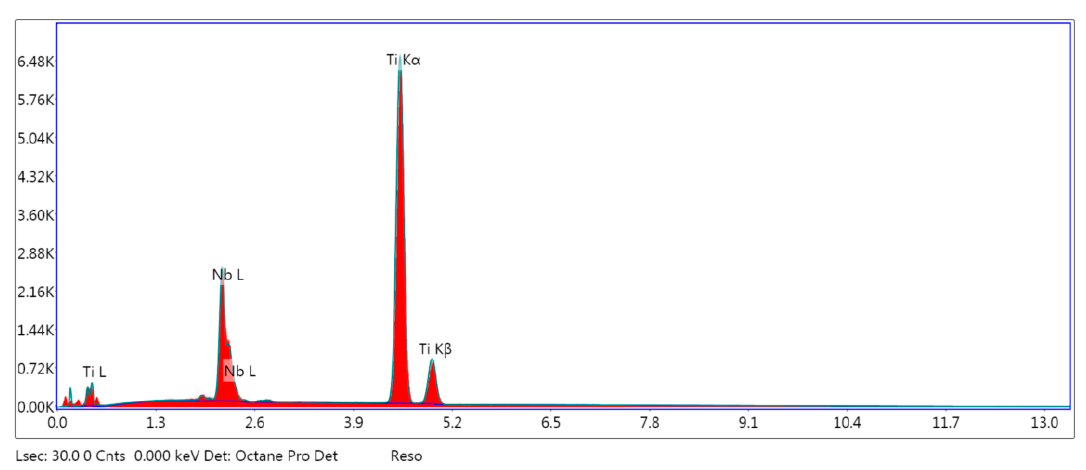
Figure 1. Energy dispersive spectroscopy (EDS) result of the fractured surface of as received sample.